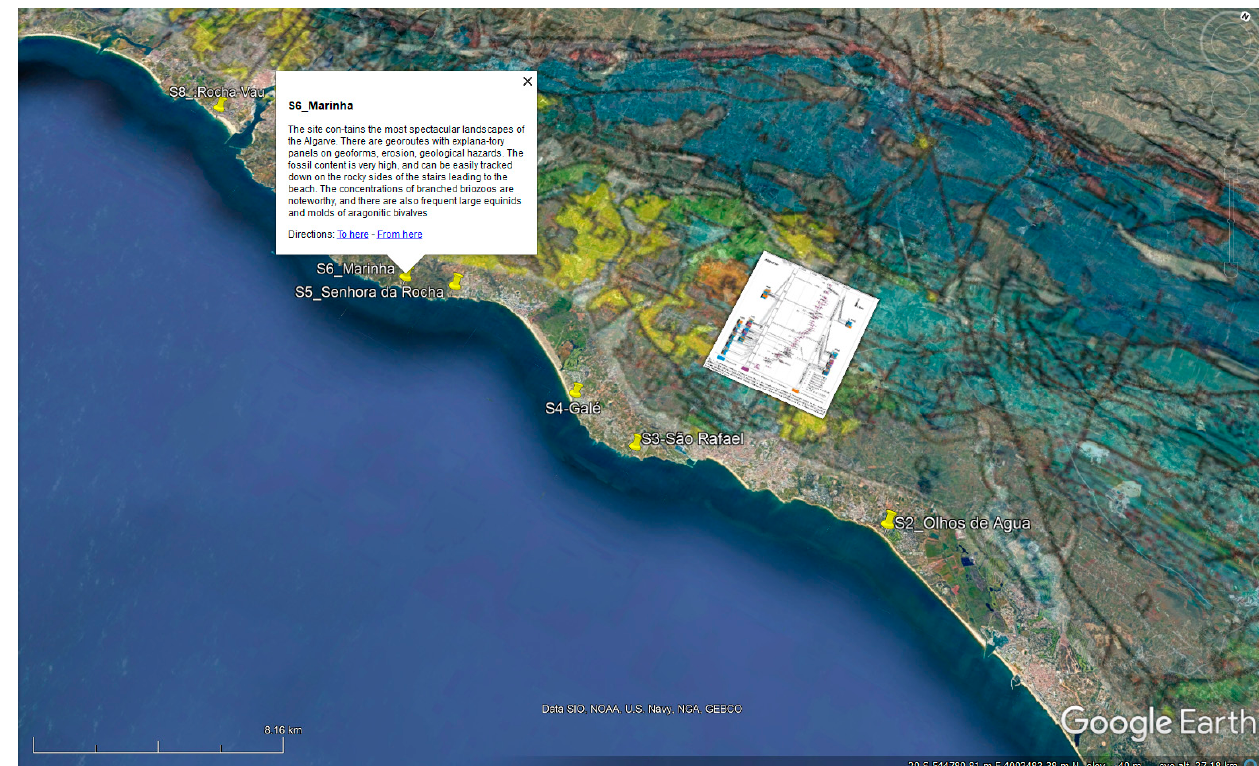
Figure 7. Capture of the geosites in the natural space of Marinha-Galé-Sao Rafael. Images of the location of some stops on geologic cartography and interpretive schemes are shown.